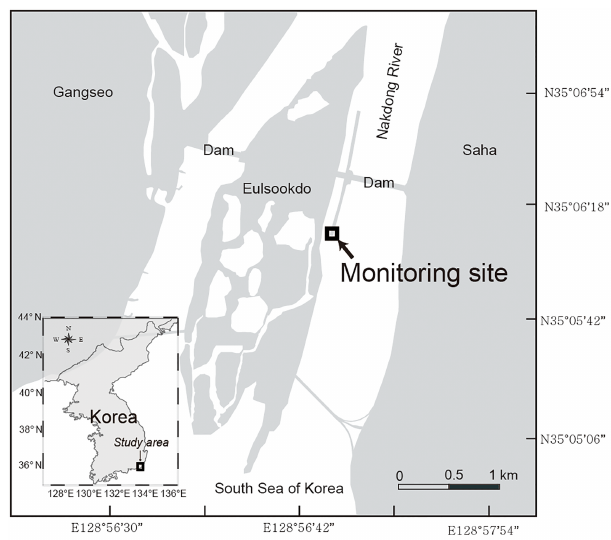
Figure 1. Map of the Nakdong River Estuary. The square indicates a fixed monitoring site located 560m downstream from the